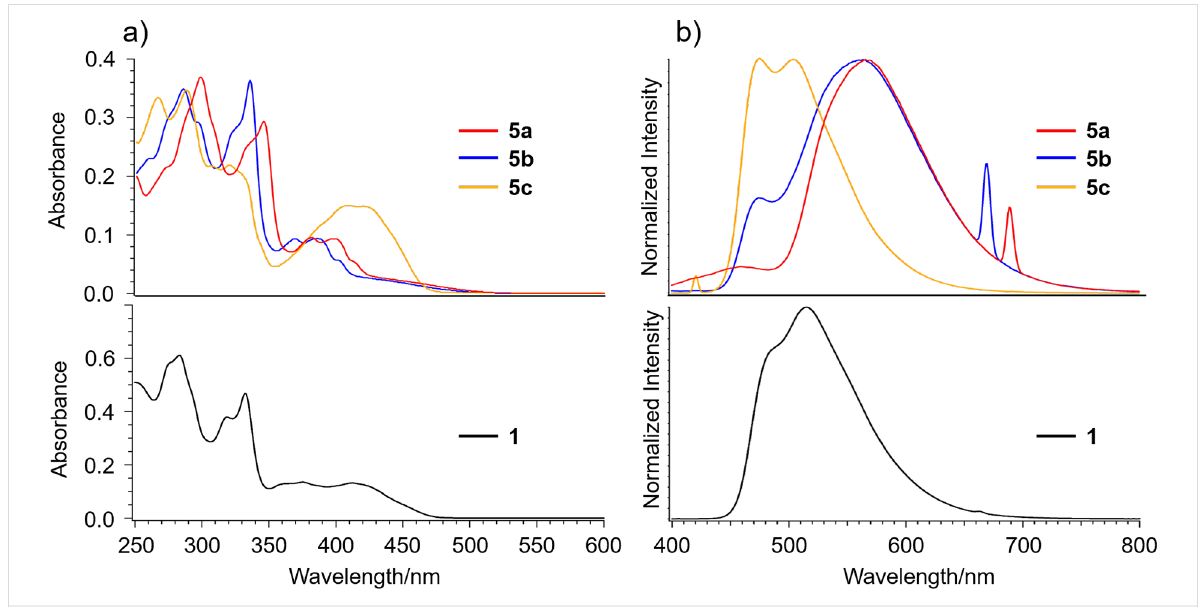
Photophysical properties of the dialkoxides were investigated by UV–vis and emission spectroscopies (Figure 6). UV–vis spectra of 5a and 5b well reflected the electric property of 1 ,